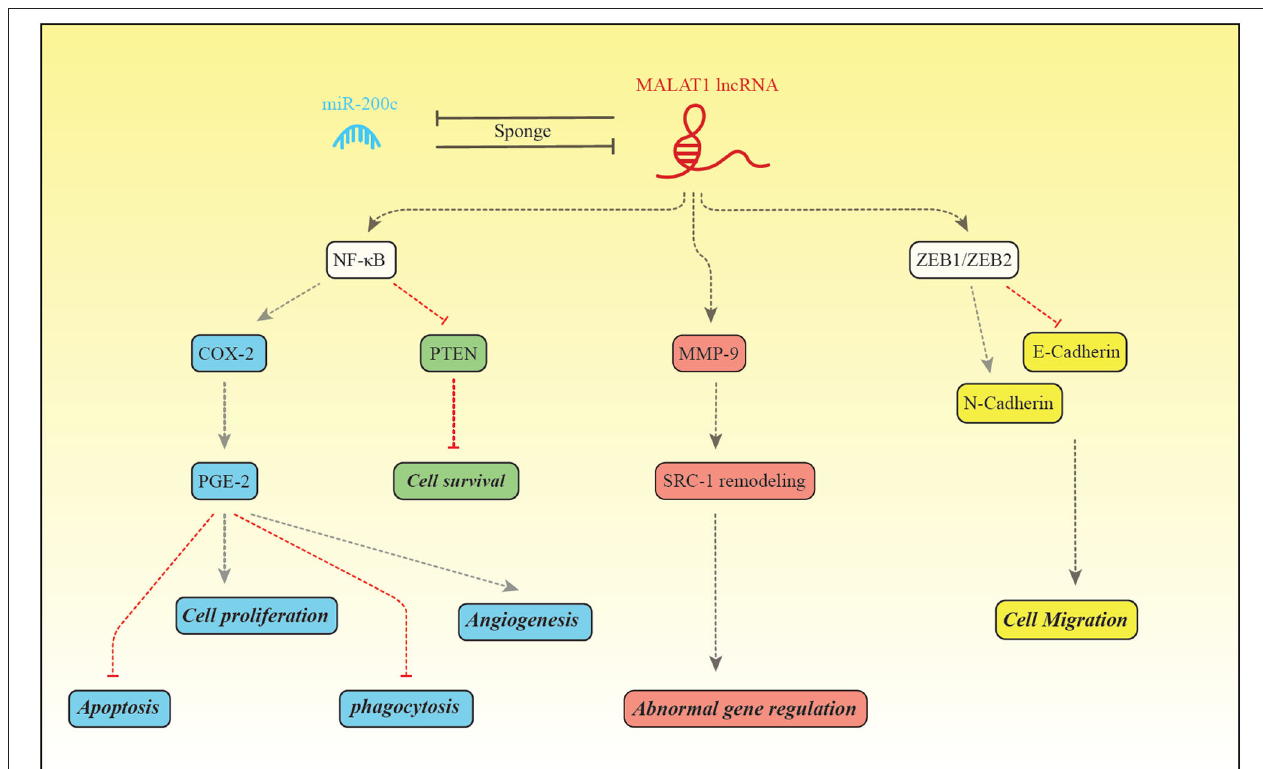
FIGURE 2 | MALAT1 and miR-200c regulate expression of each other through the sponging mechanism. Liang et al. have reported down-regulation of MALAT1 and up-regulation of miR-200c in patients with endometriosis ( 48). MALAT1 increase expression of NF- κ B which in turn binds with PGE-2 to enhance its expression (99). PGE-2 activates BCL2/BAX through interaction with EP2/EP4 receptor and suppresses intrinsic apoptotic pathway ( 100). PGE2 also activates cell proliferation through EP2/EP3 ( 101). In addition, PGE-2 suppresses MMP2, CD36 and annexin A2 in macrophages, thus inhibits phagocytic activity of macrophages. These effects facilitate implantation and growth of endometrial tissue in the peritoneum (101). PGE-2 influences angiogenic activity and cell cycle progression through increasing expression of VEGF and inhibiting PTEN, respectively (99). MALAT1 can enhance MMP9 levels. MMP9 increases production of the truncated isoform of Steroid receptor coactivator-1. MALAT1 also increases transcription of ZEB1/ZEB2, therefore induces mesenchymal cell phenotype which is accompanied by enhancement of cell migration